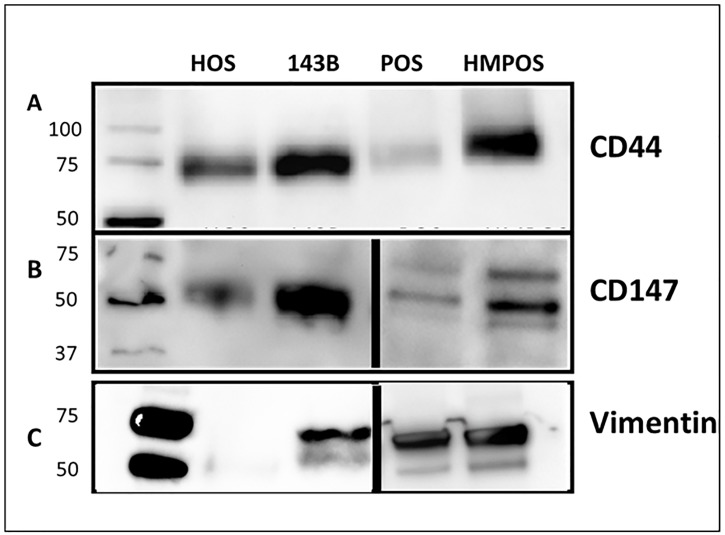
Western blot showing the expression of (A) CD44, (B) CD147 and (C) Vimentin.Lanes from left to right: ladder, HOS, 143B, POS and HMPOS. HOS and POS are the non-metastatic human and canine cell lines and 143B and HMPOS are the metastatic human and canine cell lines respectively.